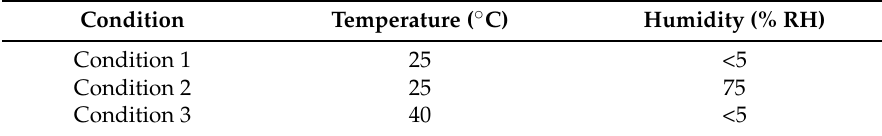
Table 1. Different storage conditions of sodium naproxen-lactose systems.